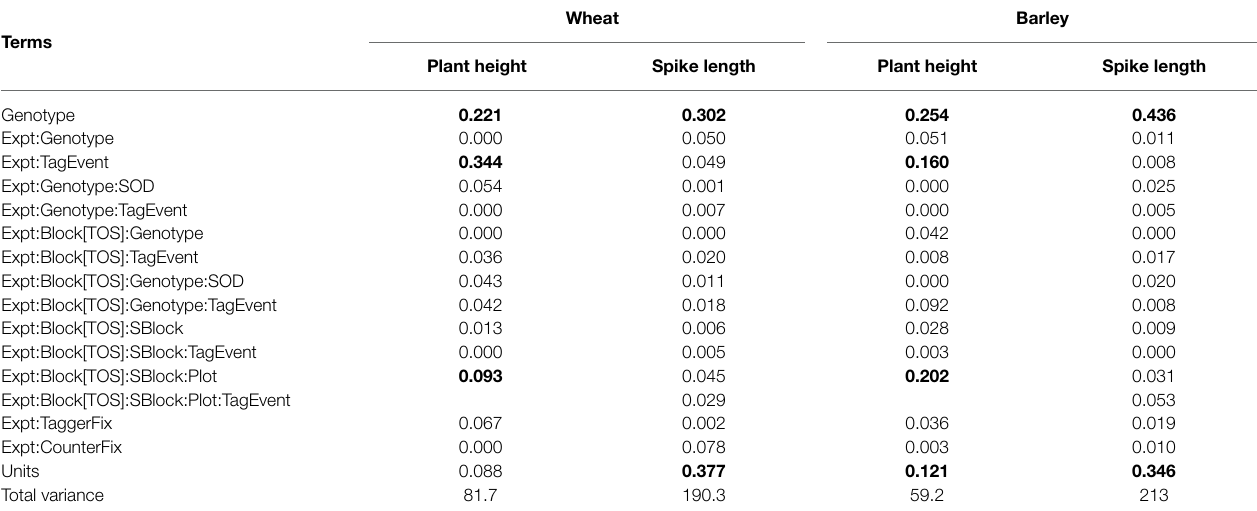
TABLE 8 | Summary of the variance associated with random terms for plant height and spike length. Values are expressed as a proportion of total variance (the final row of the table), and those which are zero are less than 0.0001. Note the term associated with spike variation within tag events for each FEE is the units for plant height. Numbers in bold show the major source of